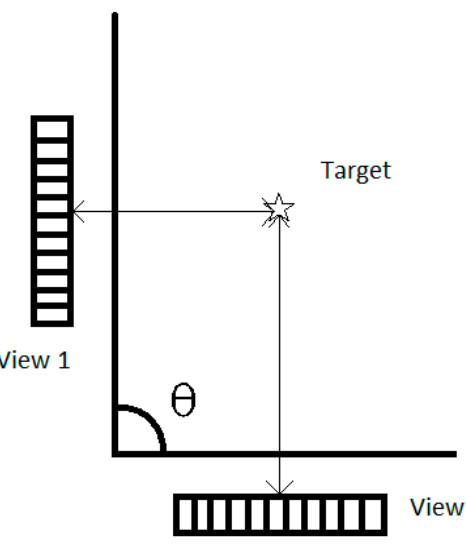
Figure 7. Simplified multi-view scenario.